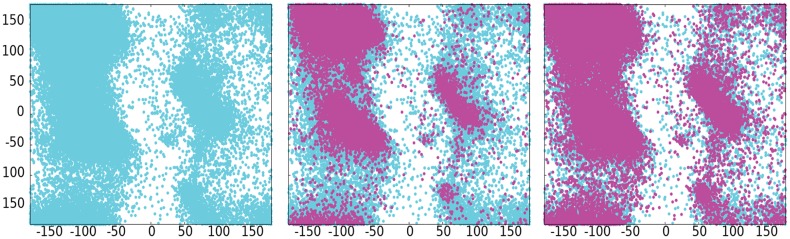
Ramachandran plot.Left: Ramachandran plot for 1E0L of PSI libraries 3-20-mers. Middle: Superposition of the Ramachandran plot for 3-20-mers (blue) and 3-mers (purple). Right: Superposition of the Ramachandran plot for 3-20-mers (blue) and 3,6,9-mers (purple). Similar plots are obtained for all the other protein fragment libraries.